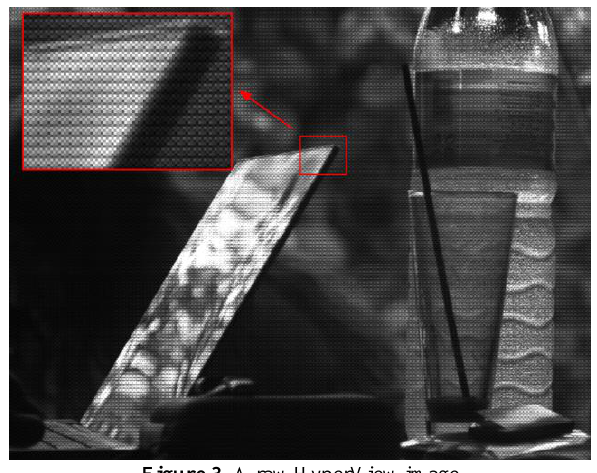
Figure 3 . A raw HyperView